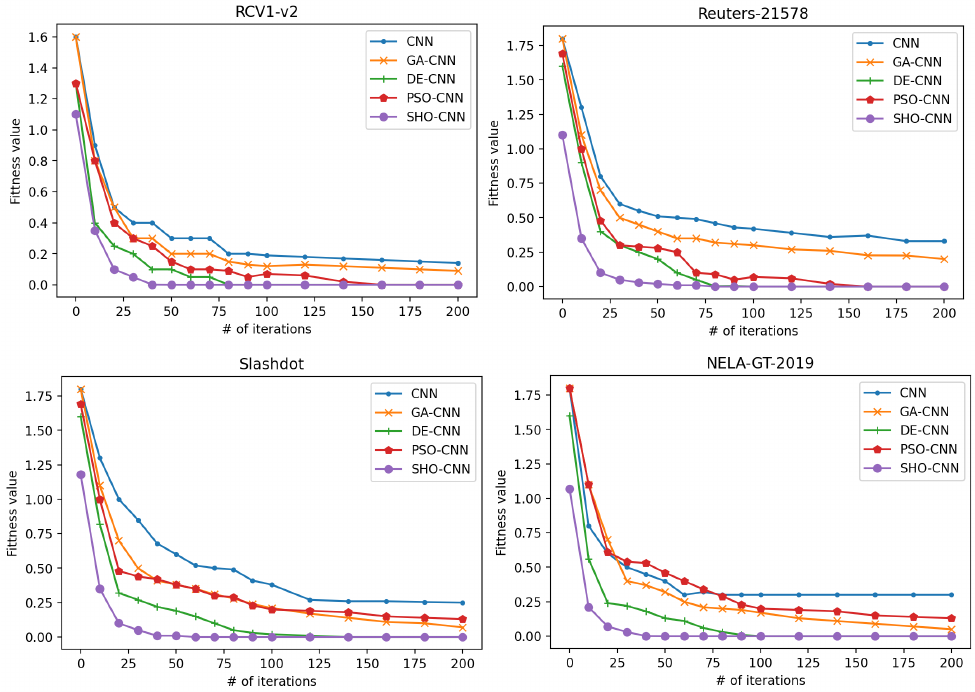
Figure 4. Evaluations based on convergence